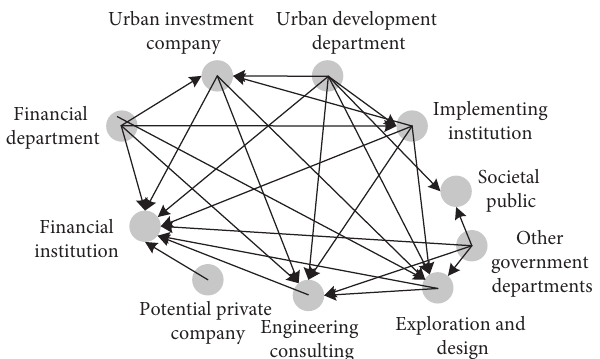
Figure 1: Trust network in competitive bidding stage of PPP project (Model 1).